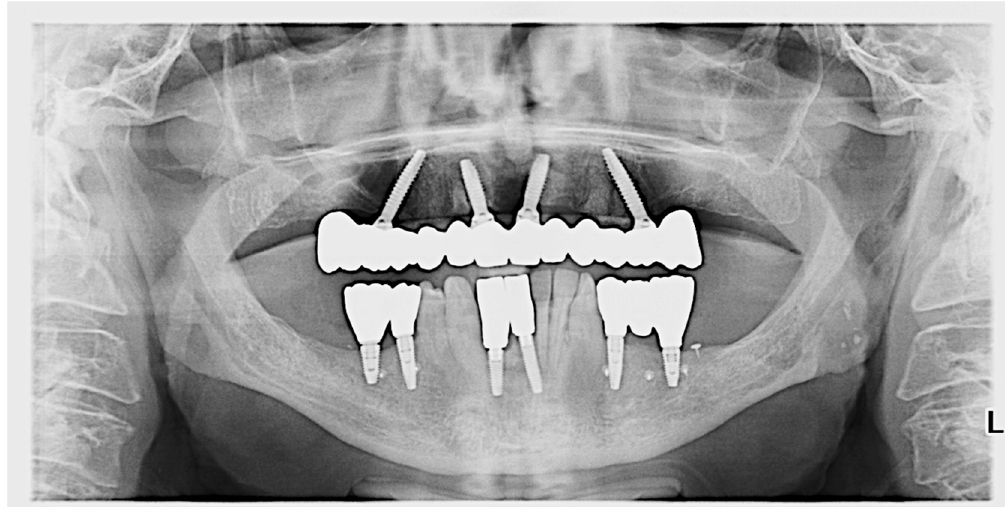
Figure 11. Three-year follow up of the final restoration.